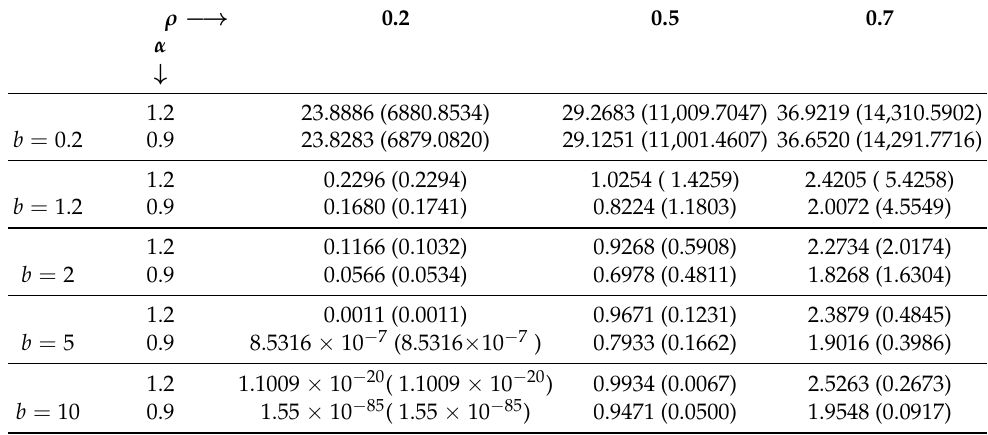
Table 1. The mean (variance) of DWMOE( α , b , ρ ) for different values of